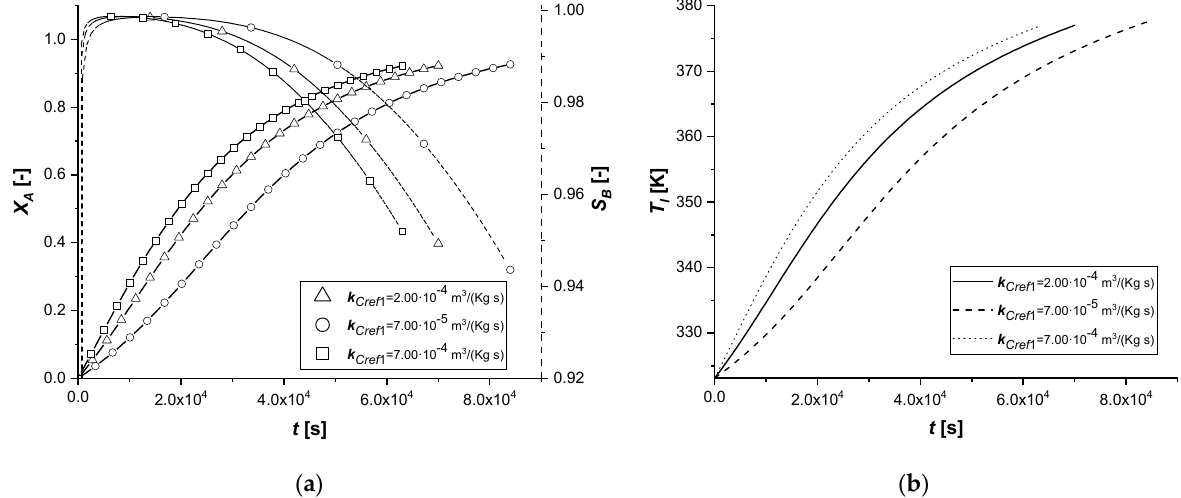
Figure 12. EW k Cref 1 investigation. ( a ) Bulk profiles over time of X A and S B . ( b ) Bulk profile of T l over time.